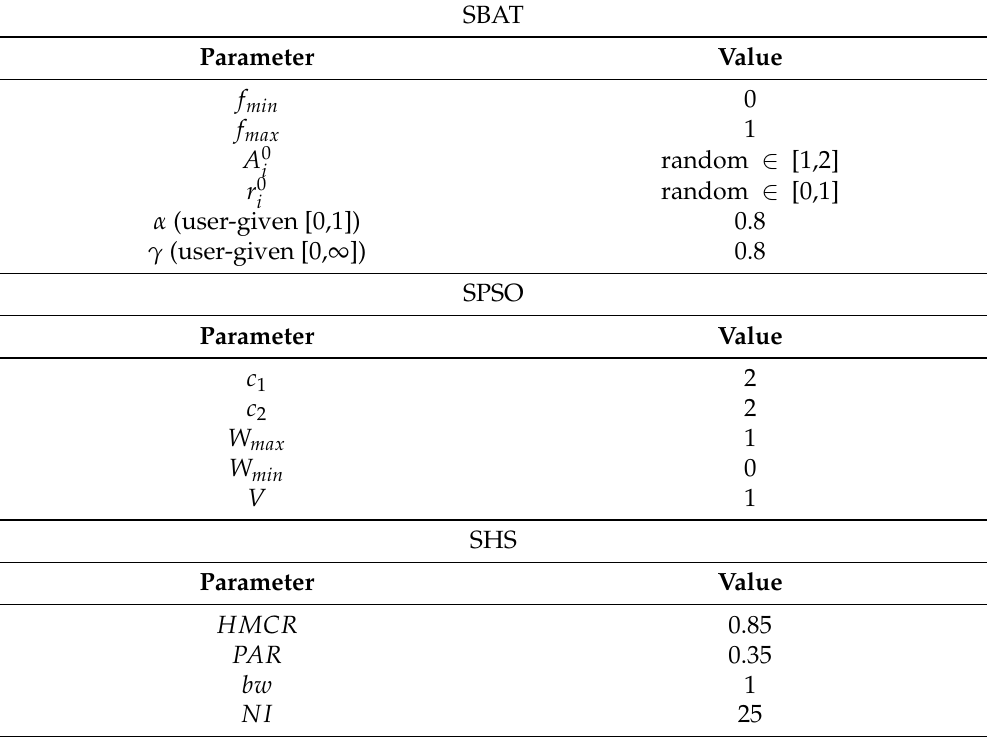
Table 1. Algorithms’ fixed parameters.